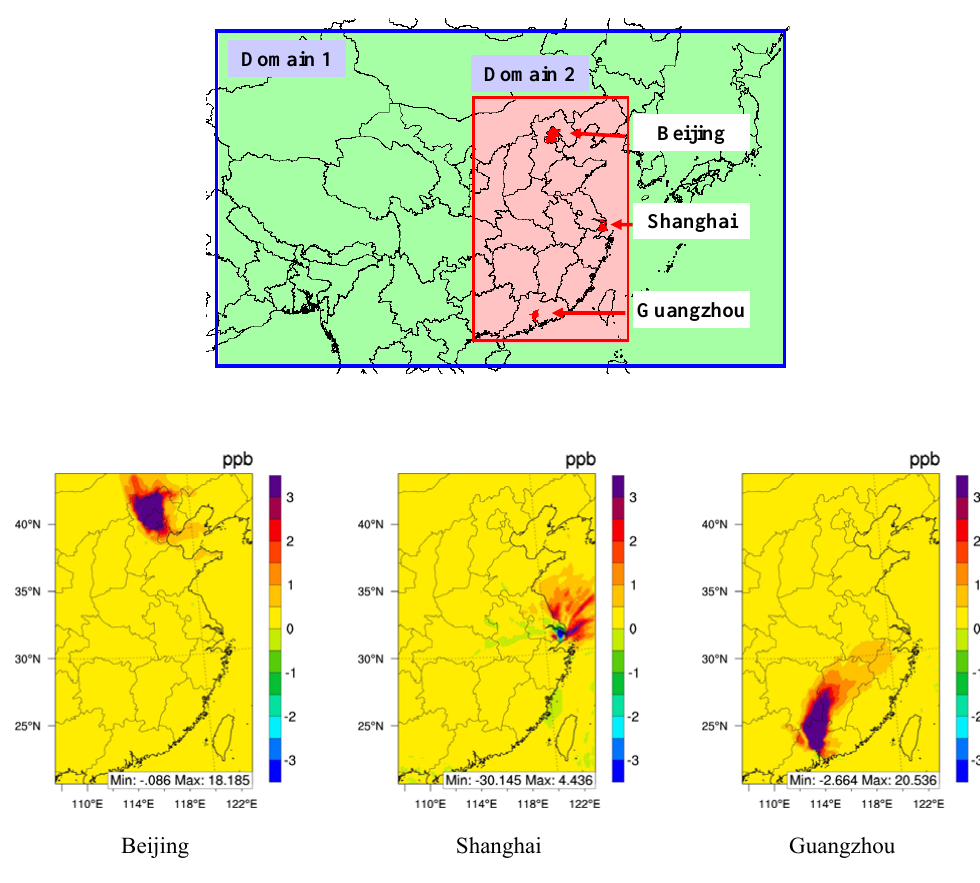
Fig. 2. Map of the CMAQ/RSM modeling domain and interactions among three cities. (a) CMAQ and RSM modeling domain; (b) change in ozone concentration (Baseline scenario minus the control scenario which zeroed out all emissions in three cities, monthly mean of 1-h daily ozone maxima in July 2005,